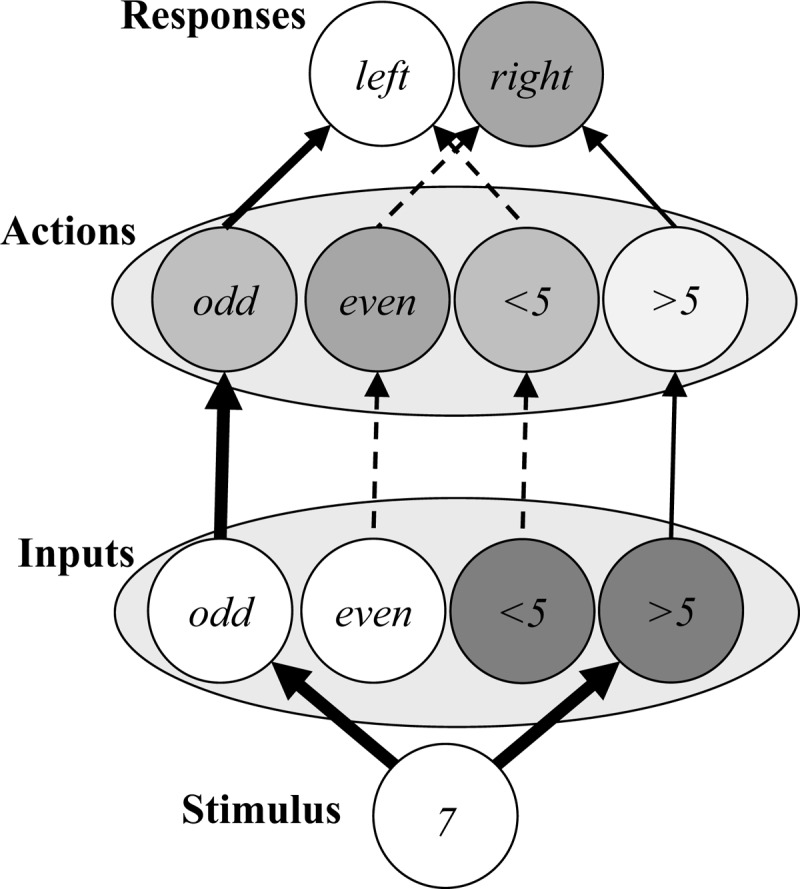
Simplified visual representation of the CARIS model as it applies to cued task switching. The inputs are filtered in favour of the current task (parity, white shading) and against the other task (dark shading). Actions are partially filtered on the basis of the prior task (in this example, magnitude) and also on the basis of whether the response on the prior trial was linked to the same or different action. The model contains a number of other parameters (not represented here) for fitting specific effects. Notes: brightness = filtering advantage for Actions and Inputs and activity level for Stimuli and Responses, arrow thickness = coactivation strength, dashed arrows = currently-irrelevant connections.